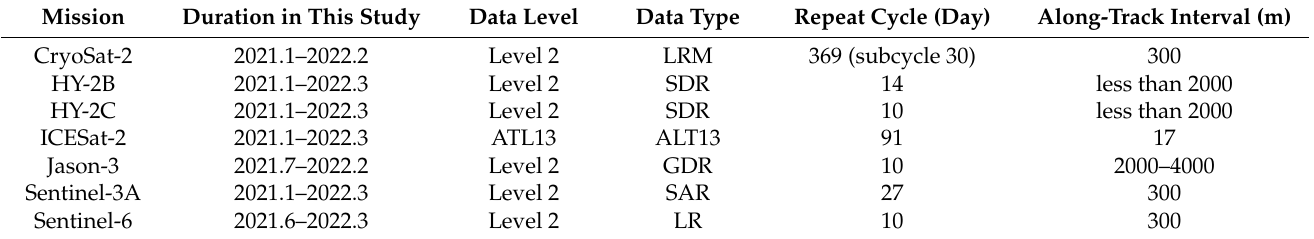
Table 2. Details of the selected satellites and their data in the